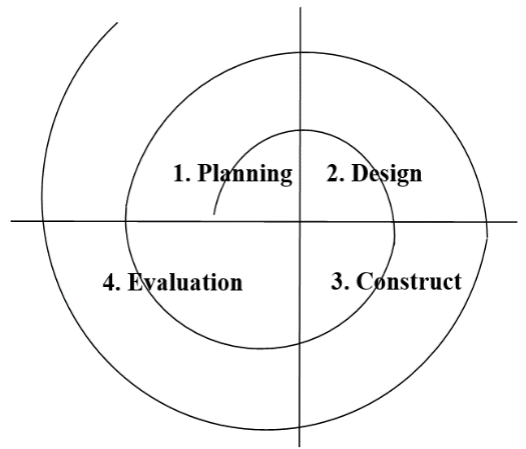
Figure 2. The spiral model of software development life cycle.